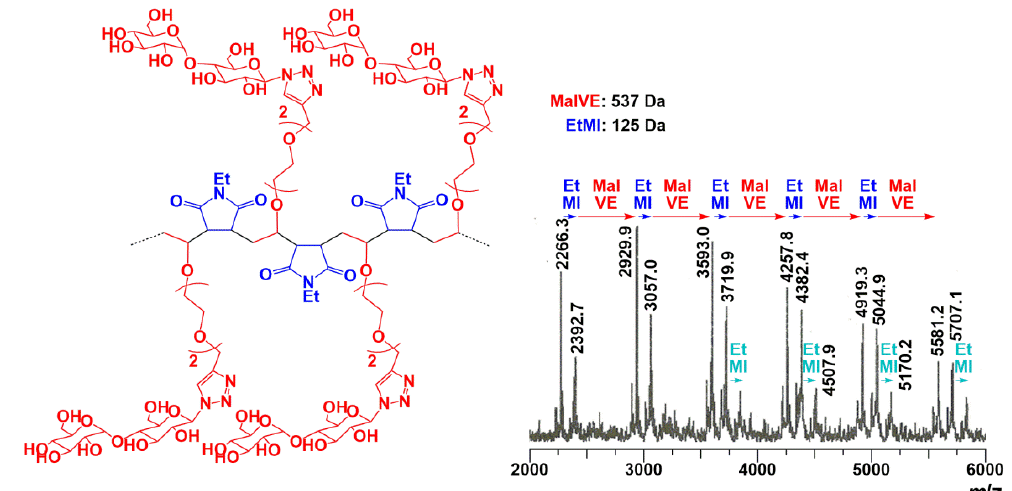
Figure 5. MALDI-TOF-MS spectrum of poly(MalVE- co -EtMI).